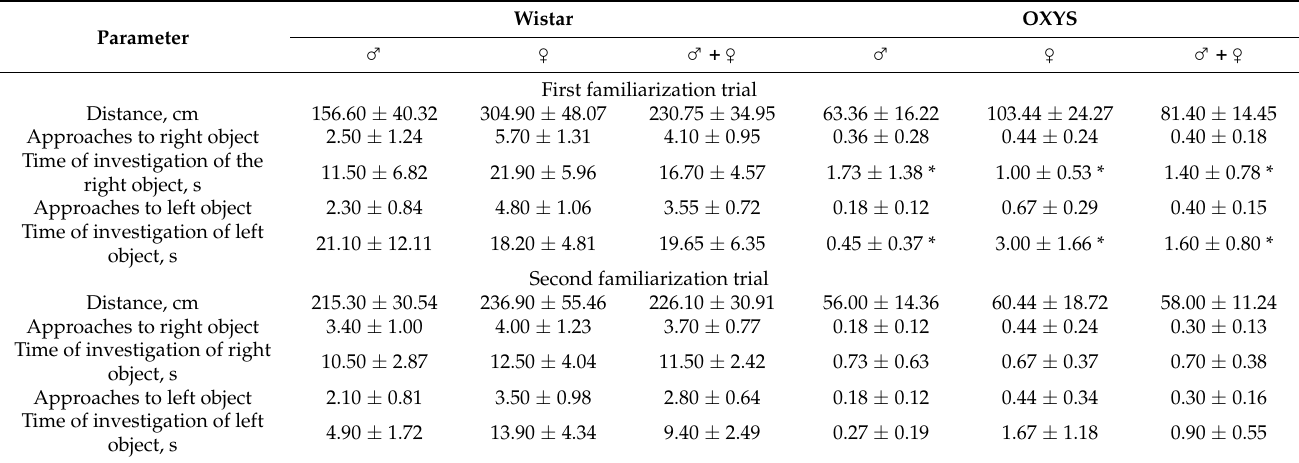
Table 8. Assessment of the learning ability in Wistar and OXYS rats in the RR test